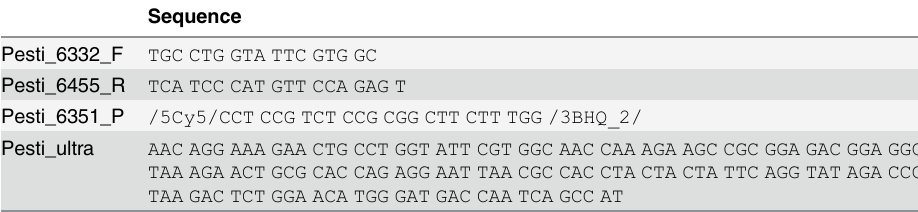
Table 1. Real-time PCR Primer, Probe and Ultramer